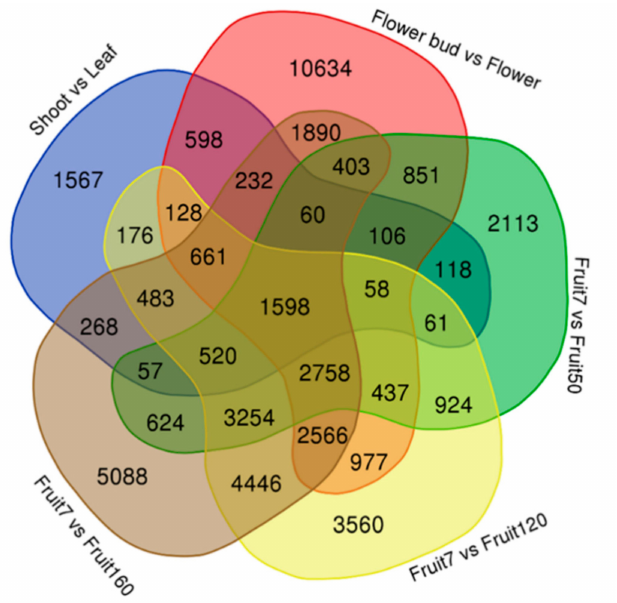
Figure 4. Venn diagram for differential expression genes between the following different plant tissues: shoot vs. leaf, flower bud vs. flower, fruit7 vs. fruit50, fruit 7 vs. fruit120 and fruit7 vs. fruit160 at p -value <